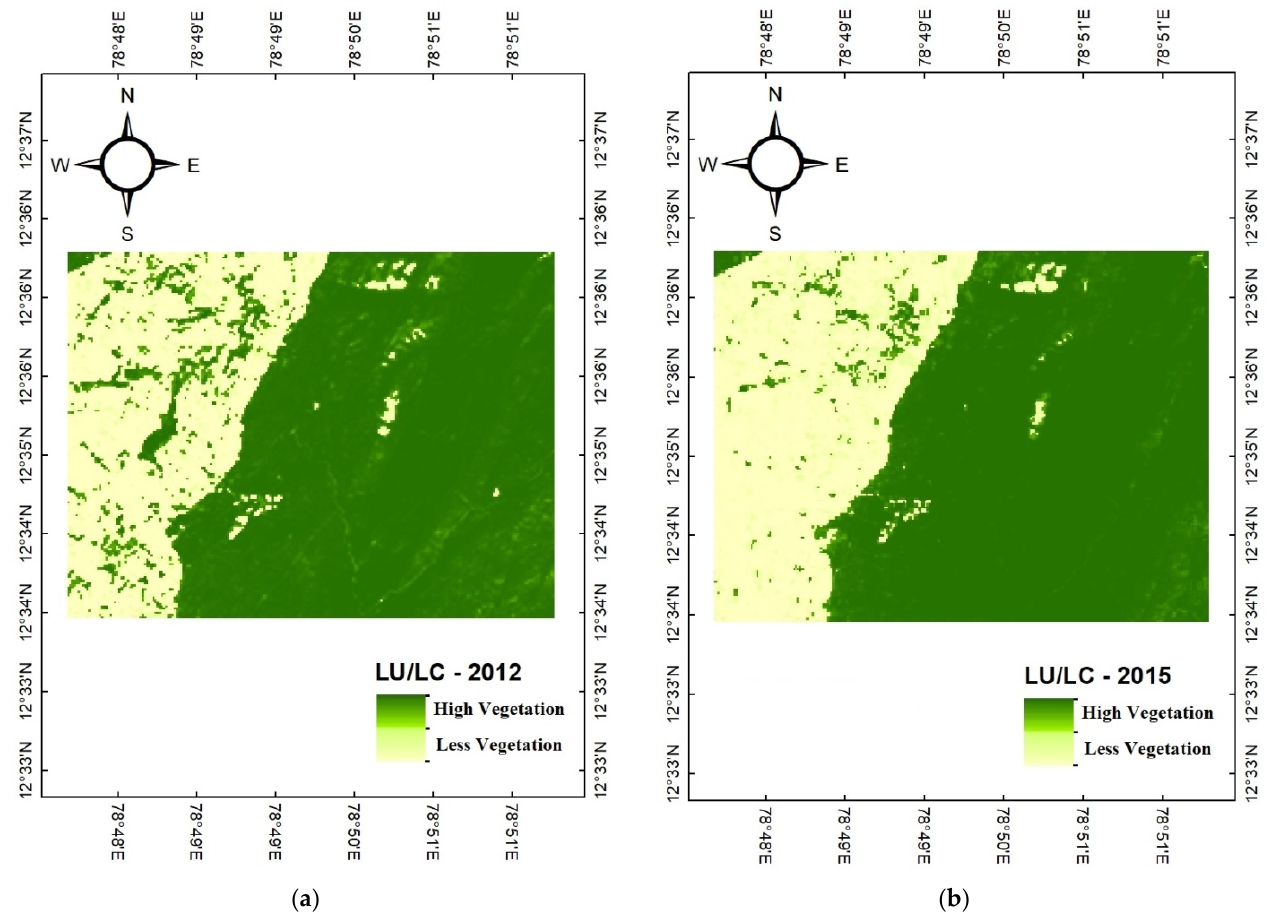
Figure 8. LU/LC classification map of Javadi Hills for the years ( a ) 2012 and ( b ) 2015.